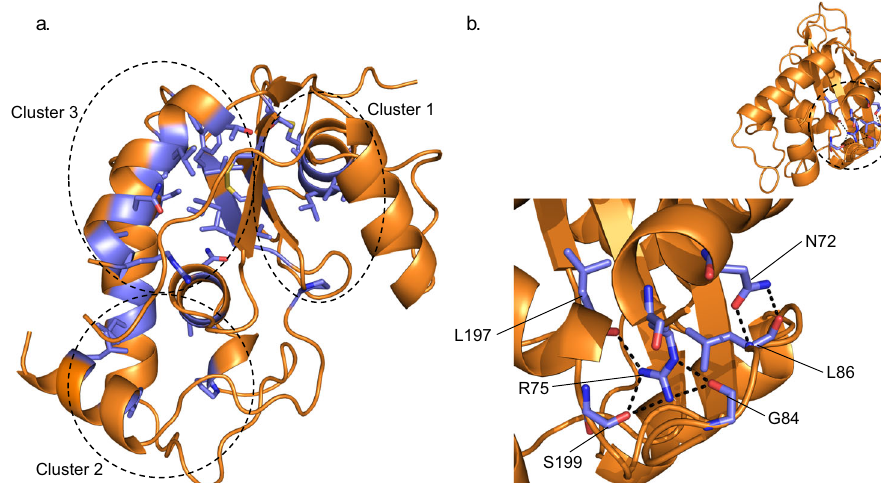
Fig. 2 Structural organisation of the conserved residues found within the SAG B sub-family members. a 3D location of the 37 conserved residues (highlighted in blue) identi fi ed within the SAG B sub-family mapped onto EtSAG19. The conserved residues can be grouped into three clusters (clusters 1, 2 and 3) as indicated by the dotted circles. b Within cluster 3 two residues, N72 and R75, are of particular interest due to their polar and buried nature. N72 and R75 are involved in an intricate hydrogen bonding network with four surrounding residues (Supplementary Table